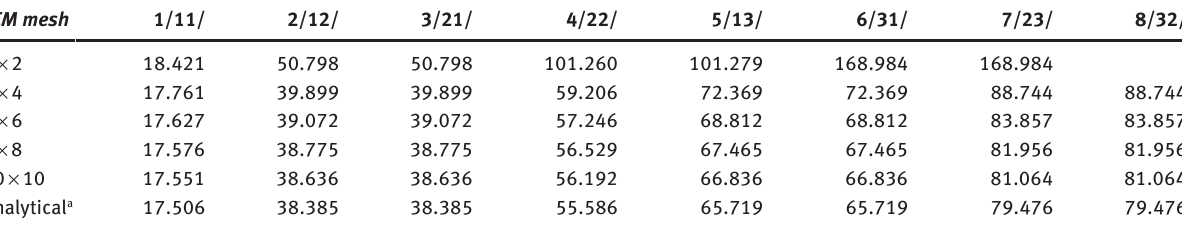
Table 4: Convergence pattern of frequency parameter µ ω ρ